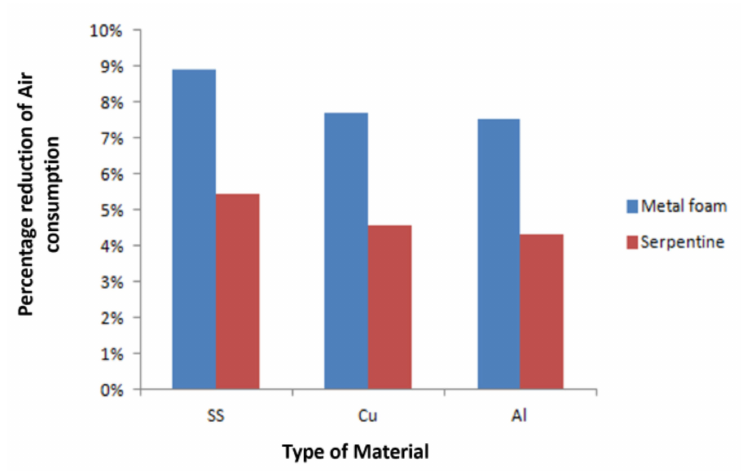
Figure 15. A comparison of percentage reduction of Air consumption between Al, Cu and SS bipolar plate material between metal foam and serpentine flow field channel.